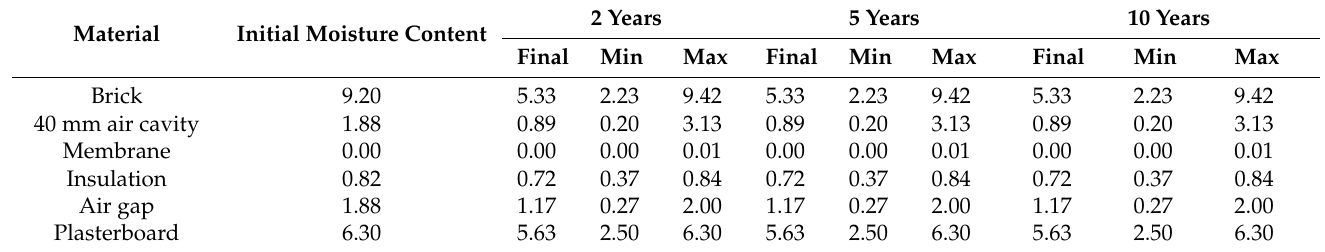
Table 10. Water content properties of 7-star clay masonry veneer wall—west orientation (kg/m 3